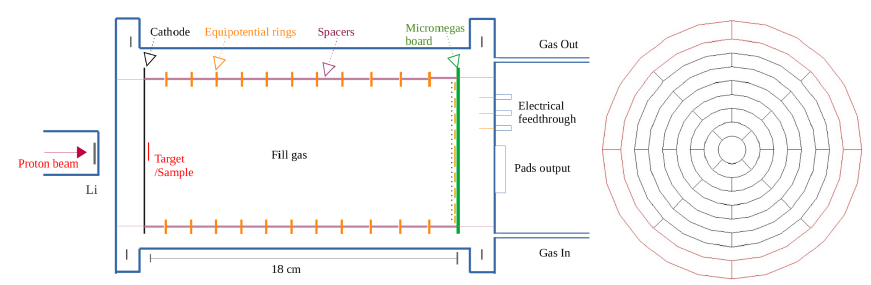
Figure 1. (Left) Conceptual design of the experimental setup and a Micromegas-based gas filled detec- tor. (Right) Segmentation scheme of the anode